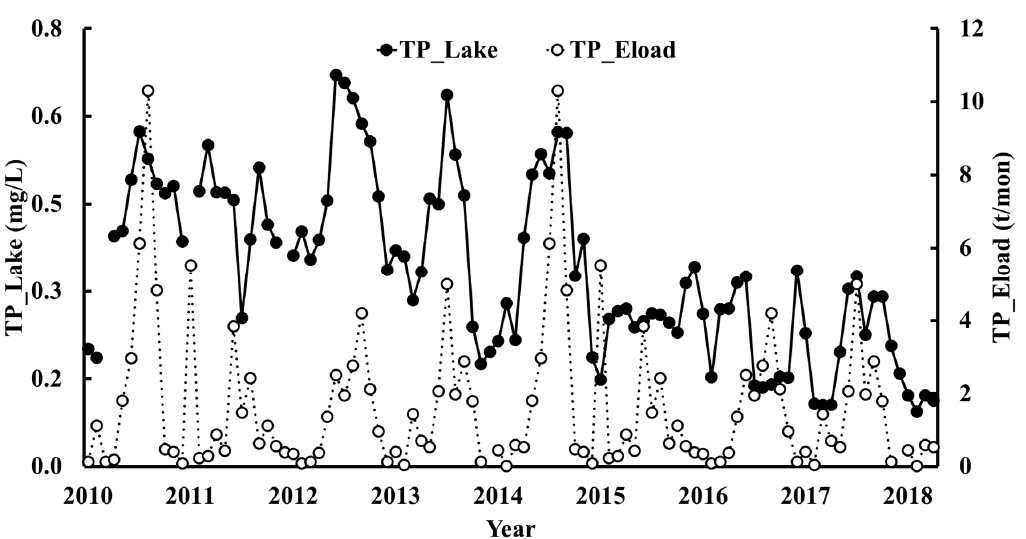
Figure 4. Monthly lake TP concentration (TP_Lake), represented by black solid circles and solid line (left Y axis), and total tributary TP inputs (TP_Eload), represented by black hollow circles and dash line (right Y axis), during January 2010–April 2018.